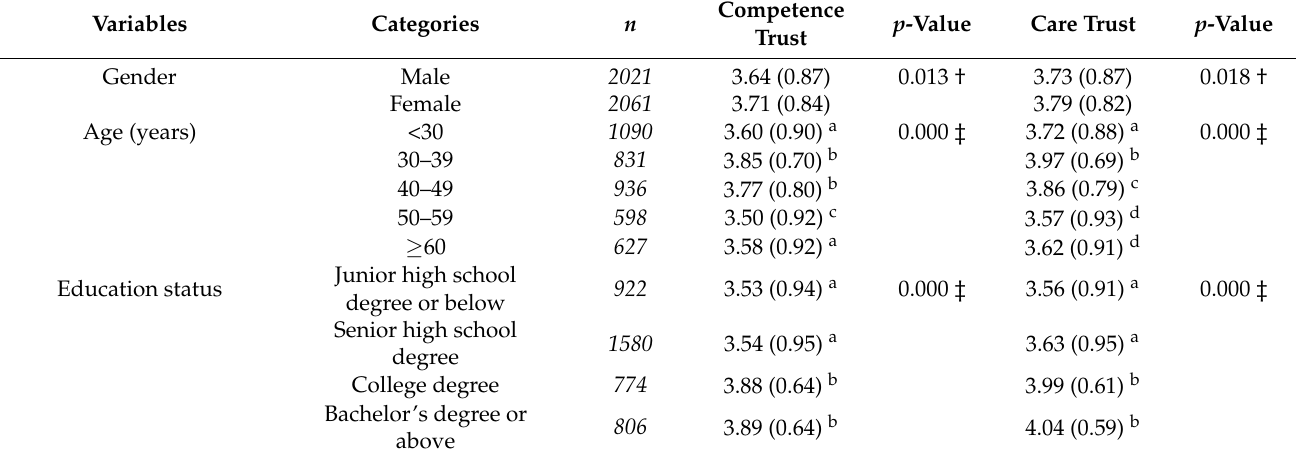
Table 2. Associations between the characteristics of consumers and competence trust and care